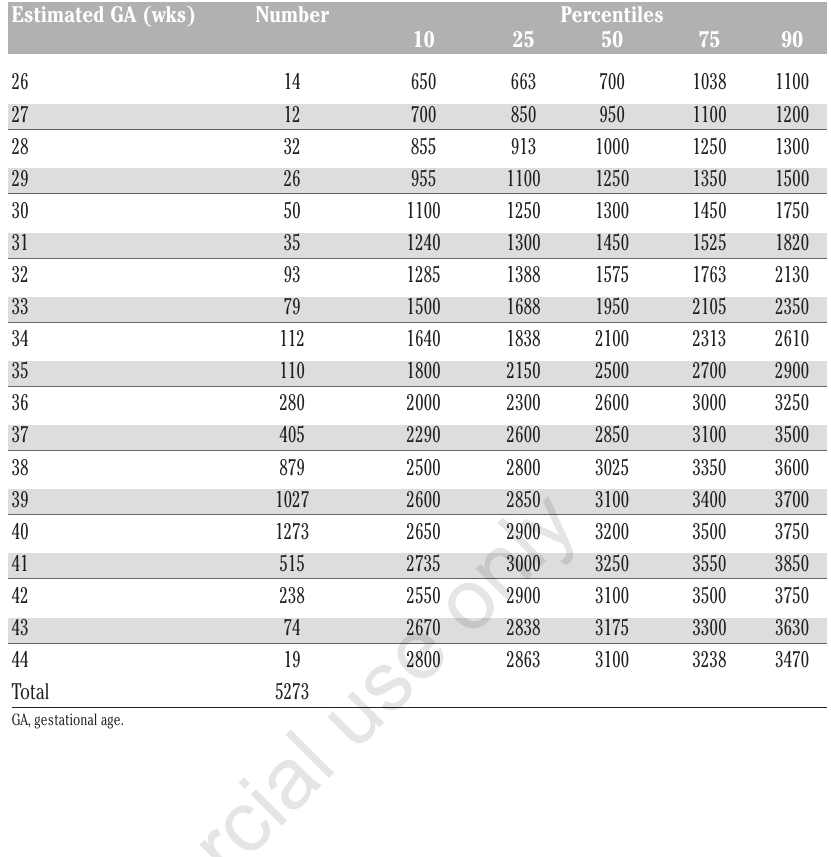
Table 1. Weight percentiles by gestational age categories.